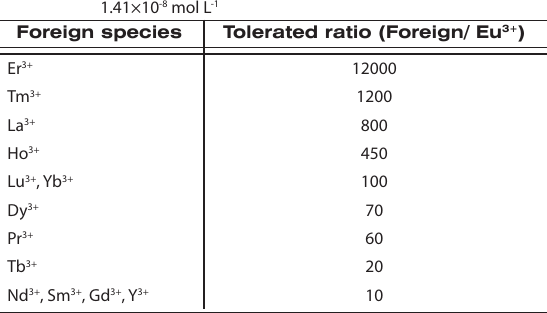
Table 2. The effect of other RE 3+ ions on the determination of Eu 3+ of 1.41×10 -8 mol L -1